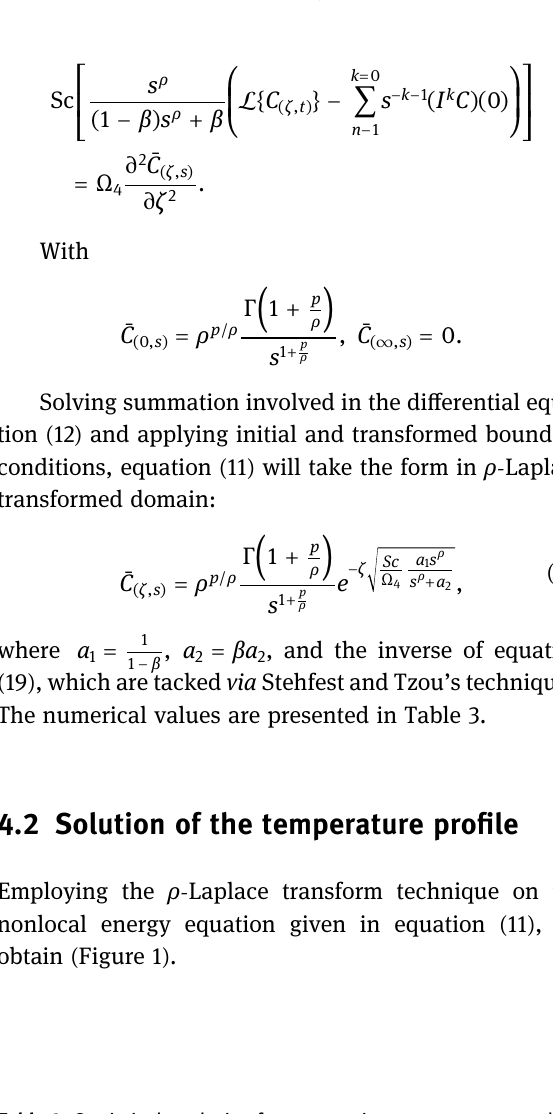
Table 3: Statistical analysis of concentration, temperature, and velocity pro fi le by both numerical